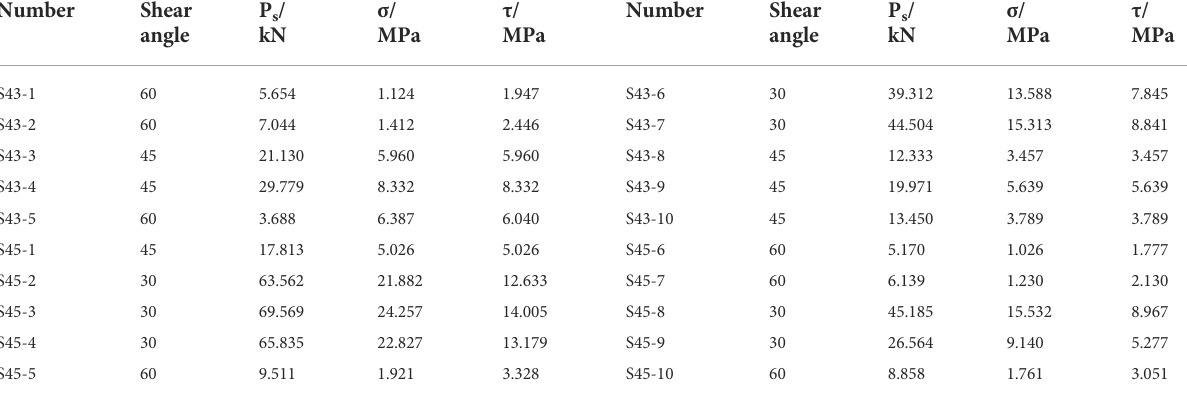
TABLE 4 Wudong Coal Mine 43#, 45# seam shear strength test results. Number Shear